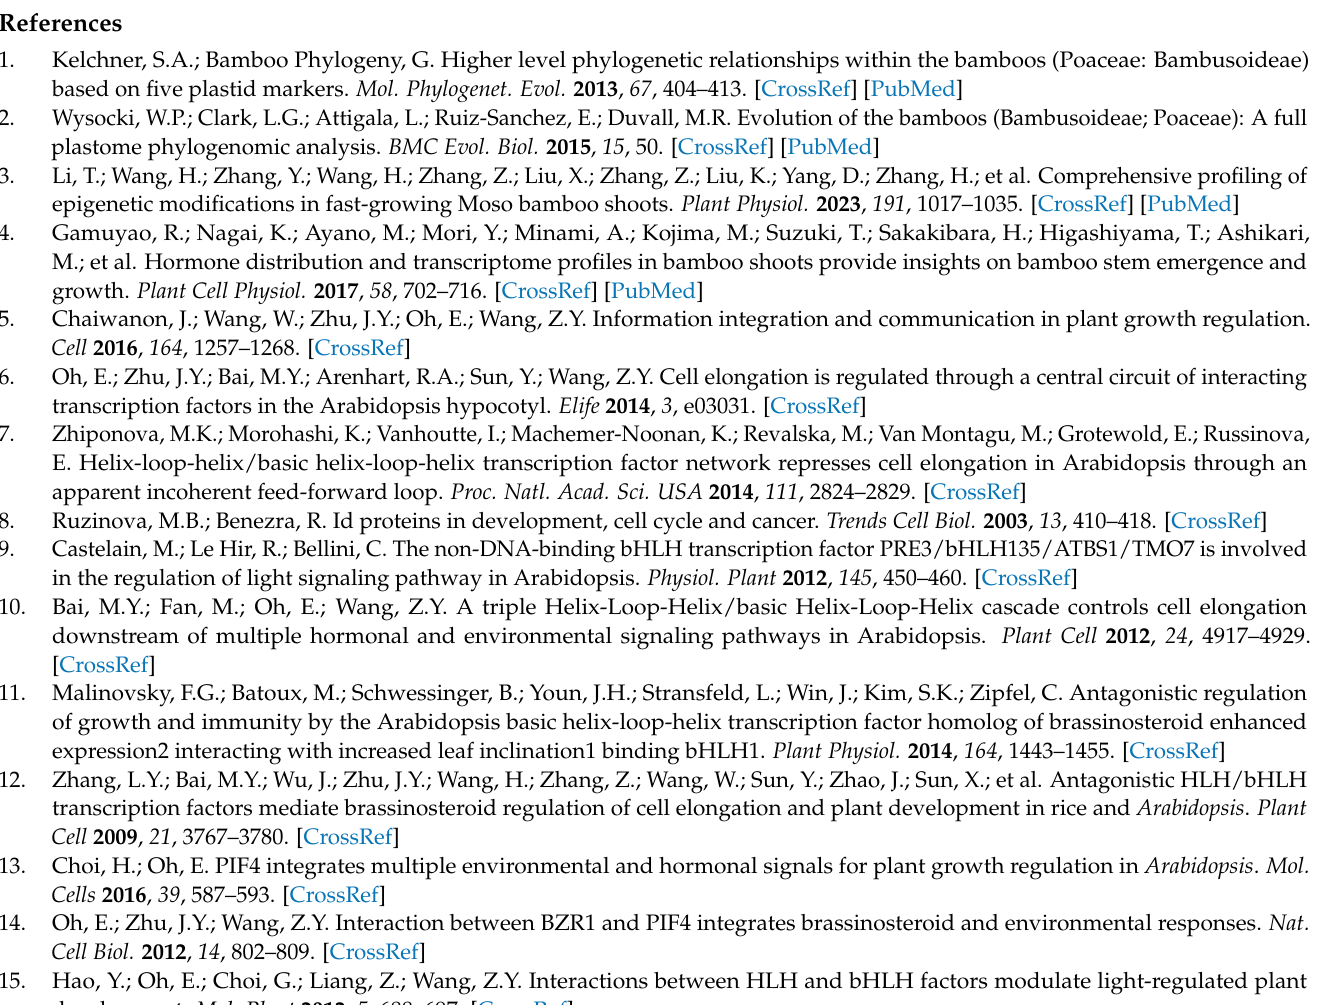
Figure A3. The PePRE1-OX transgenic seedlings were treated with PPZ. The relative hypocotyl length ( a ) and relative root length ( b ) of PePRE1-OX and control plants were treated with mock solution and a gradient concentration of PPZ. Seedlings were grown on medium containing different concentrations of PPZ for 7 days under constant light. The relative hypocotyl/root length was the average of at least 20 seedlings and normalized to the untreated seedlings. Error bars represent standard deviations.